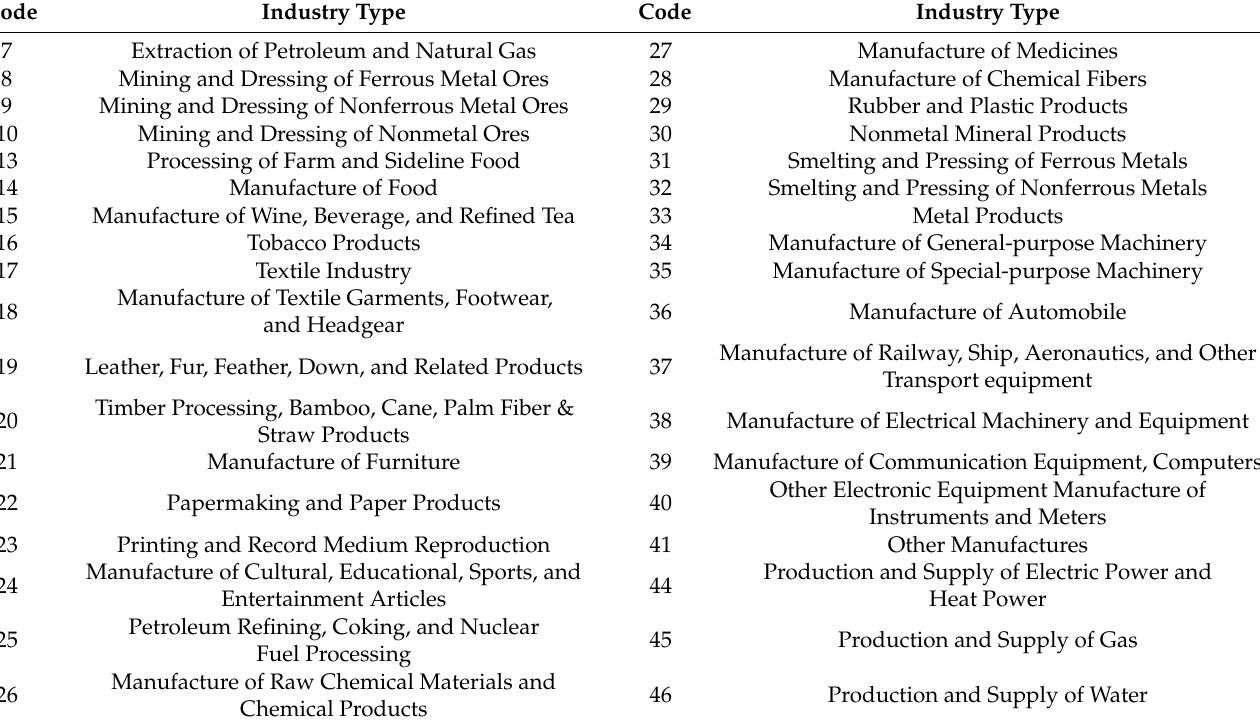
Table 1. Adjusted Classification and Codes of Industrial Sectors in